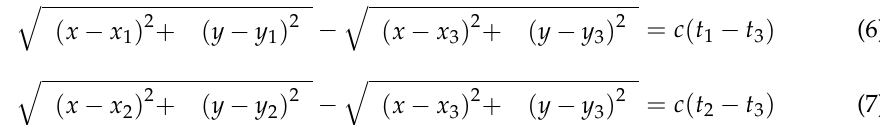
Figure 4. Hydrophone station locations.